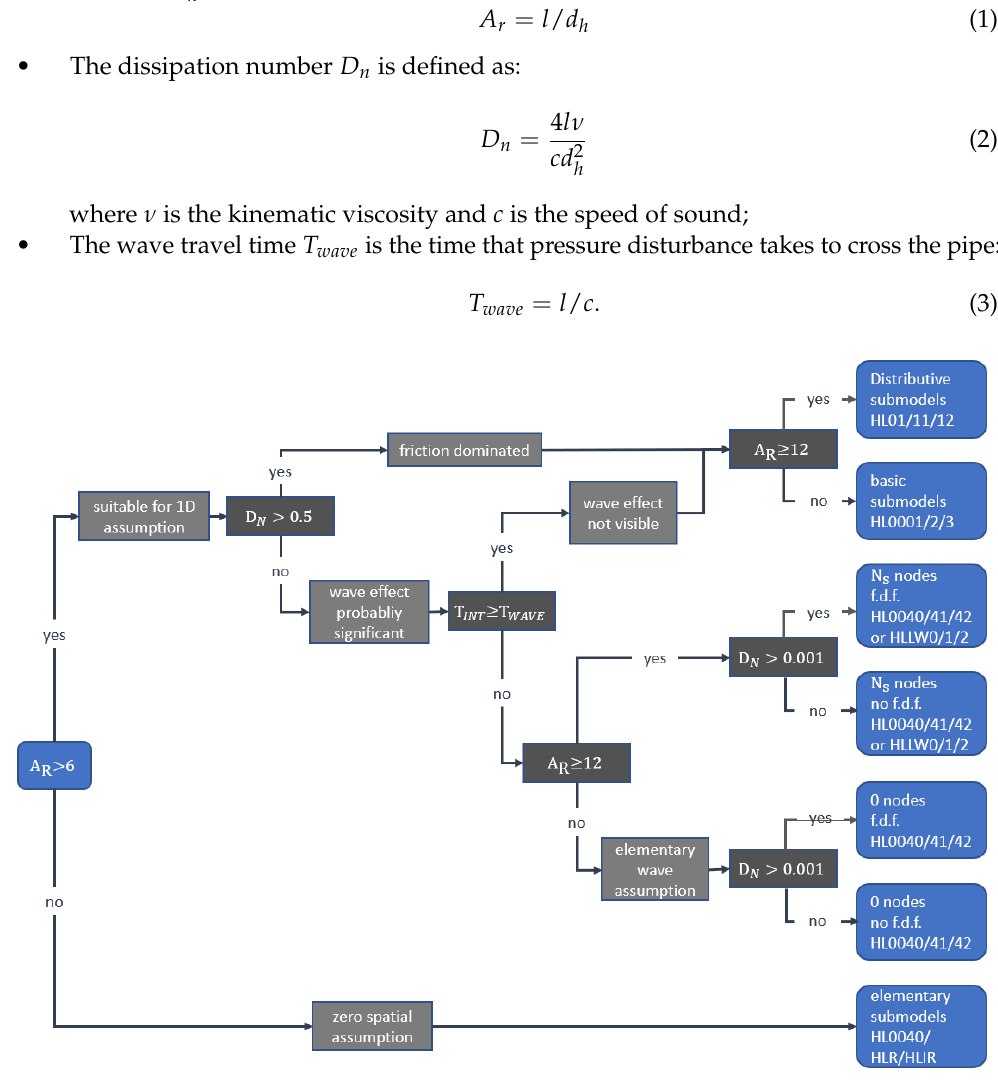
Figure 5. Flow chart for the choice of submodels of the hydraulic lines